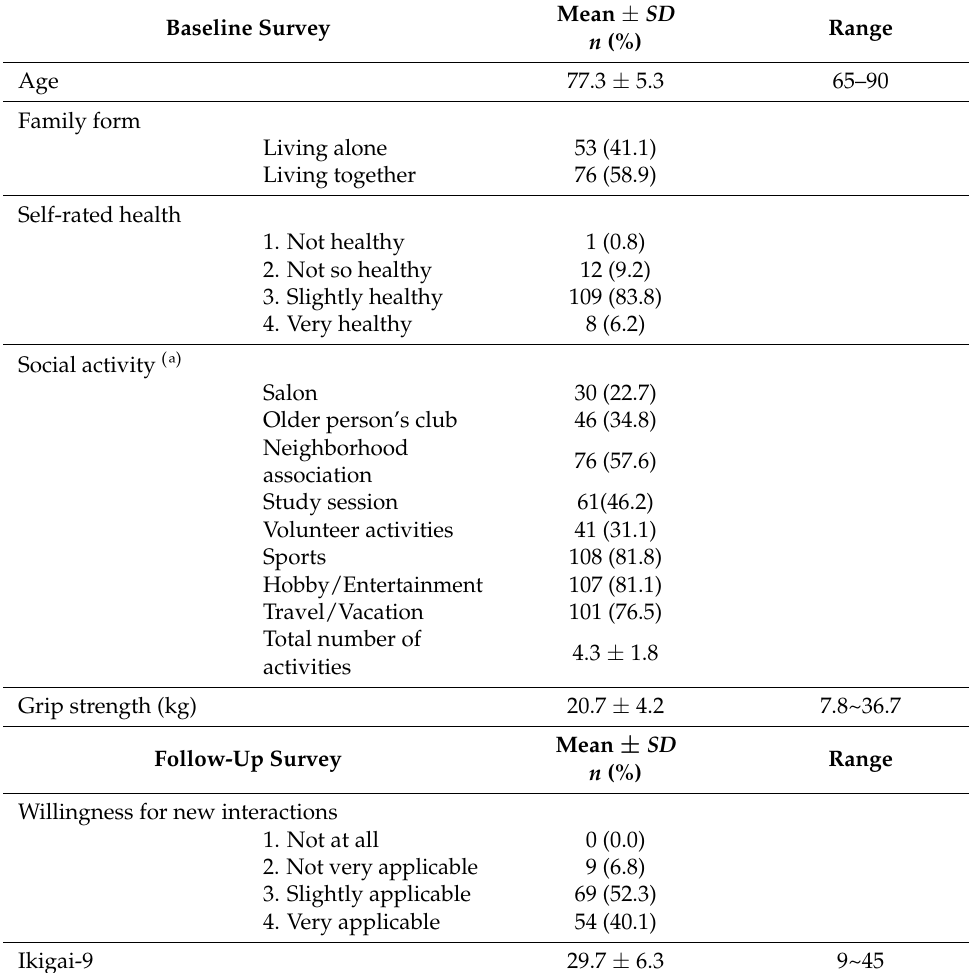
Table 2. Characteristics of the study participants. ( N = 132).